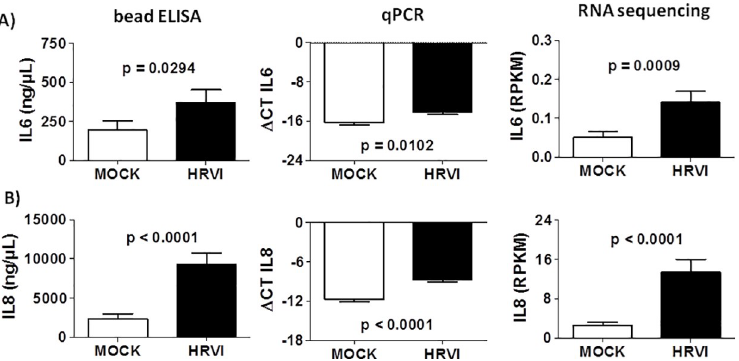
Fig 2. Increased expression of IL6 and IL8 in human nasal epithelial cells after HRVI. IL6 (A) and IL8 (B) protein (supernatant concentration) and mRNA expression (qPCR, Δ CT, RPS18 as reference gene) were increased in human nasal epithelial cells after HRVI (n = 20, Mann-Whitney test). mRNA expression was verified by RNA sequencing